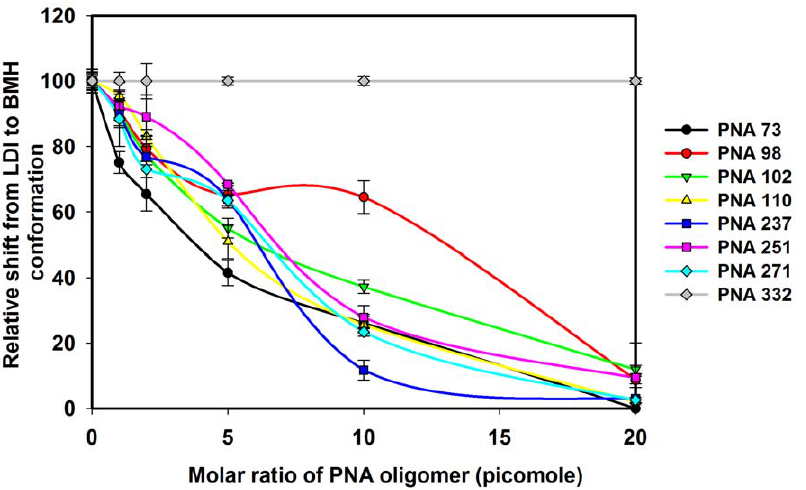
Figure 12. PNA effect on the equilibrium between the LDI and BMH conformations of HIV-1 leader RNA. The RNA samples from conformer assays were analyzed on the non-denaturing gels and the intensity of bands corresponding to the LDI and BMH conformers on each gel was quantified. The relative shift from LDI to BMH conformation was calculated as e/E 6 100%, where ‘e’ is the percentage intensity of LDI conformer in TEN buffer with different concentration of PNA oligomer and ‘E’ is the percentage intensity of LDI conformer in TEN buffer without PNA oligomers. Error bars indicate standard deviation of triplicate runs.